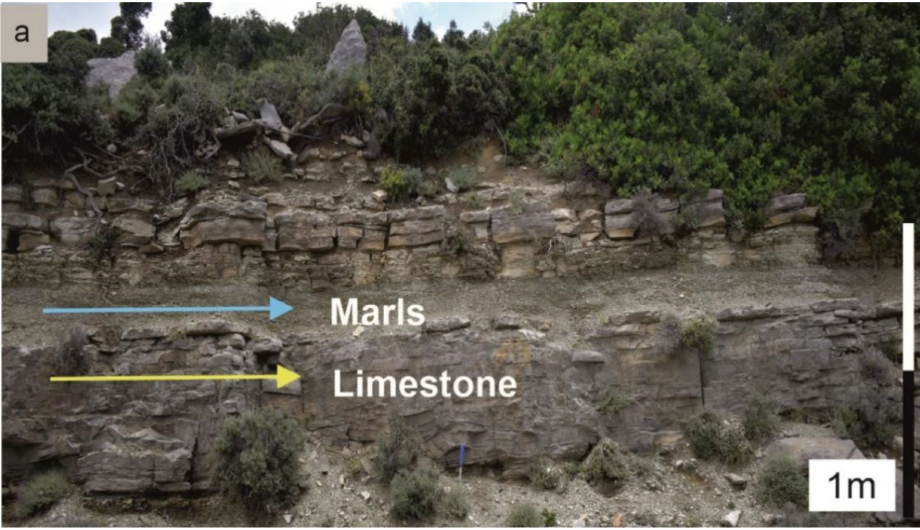
Figure 18. General view of an outcrop of the Eocene “Platy Limestones”